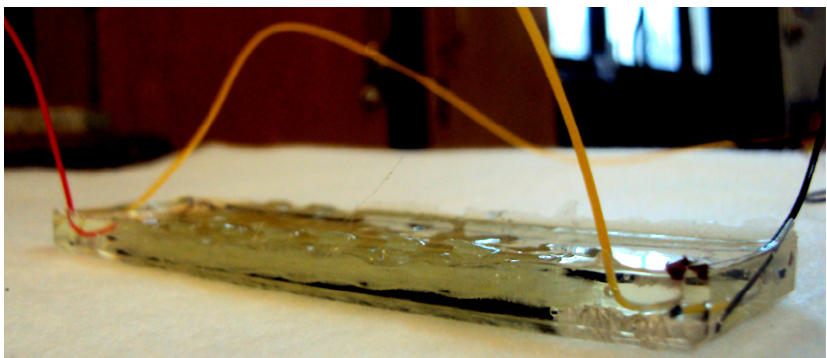
Figure 8. Glass laminated composite specimen with embedded